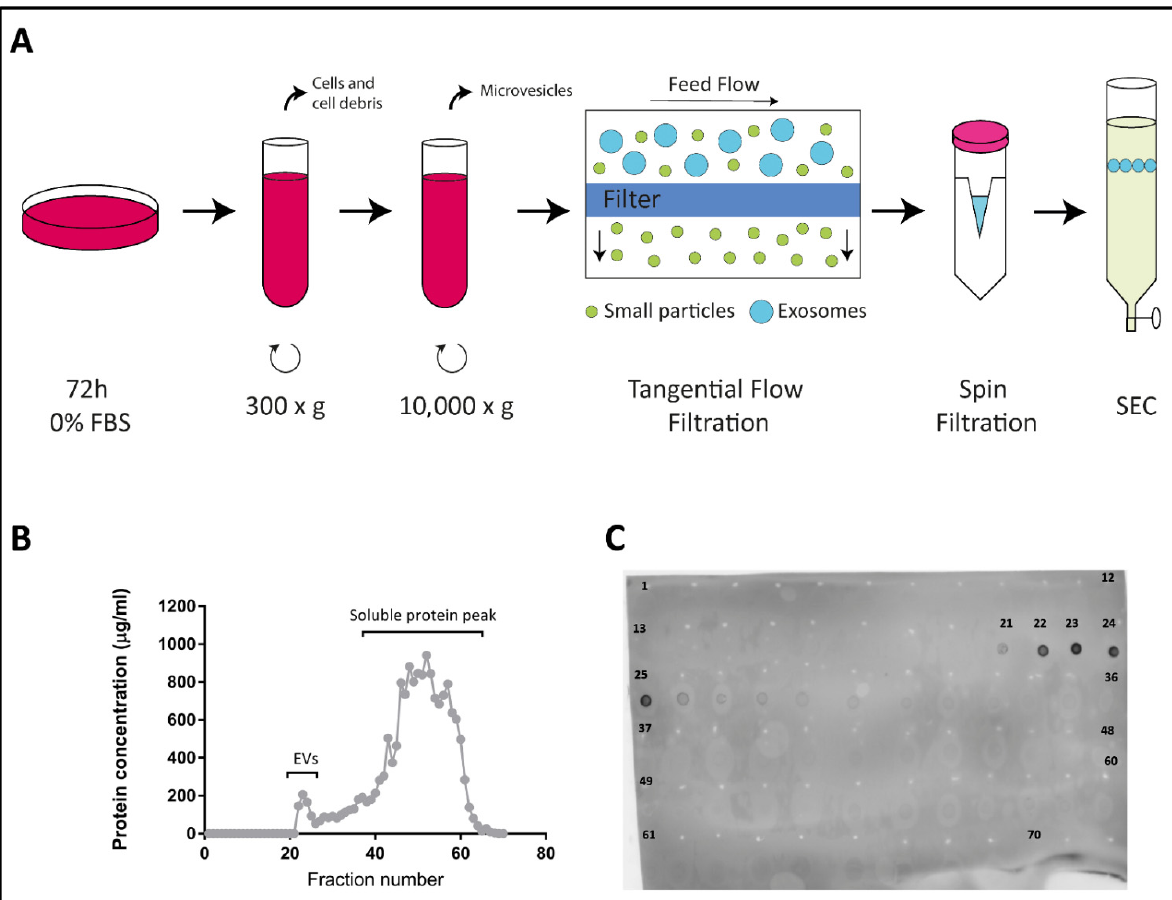
Figure 1. Isolation of exosomes from Colo-320 cells. ( A ) Experimental procedure for isolation of exosomes from conditioned medium of Colo-320 cells. Cells were cultured in serum-free conditions for 72 h before collection of the medium, which was then sequentially centrifuged at 300× g to remove cells and large debris and at 10,000× g to remove larger EVs such as microvesicles. Medium was then concentrated by tangential flow filtration and spin filtration to a final 1.0 mL volume. Exosomes were finally isolated by size exclusion chromatography (SEC). ( B ) A representative SEC elution profile showing the protein concentration of the 70 fractions (0.5 mL each) typically collected. ( C ) Dot blot showing the fractions containing exosomes, based on the presence of the exosomal marker CD81.